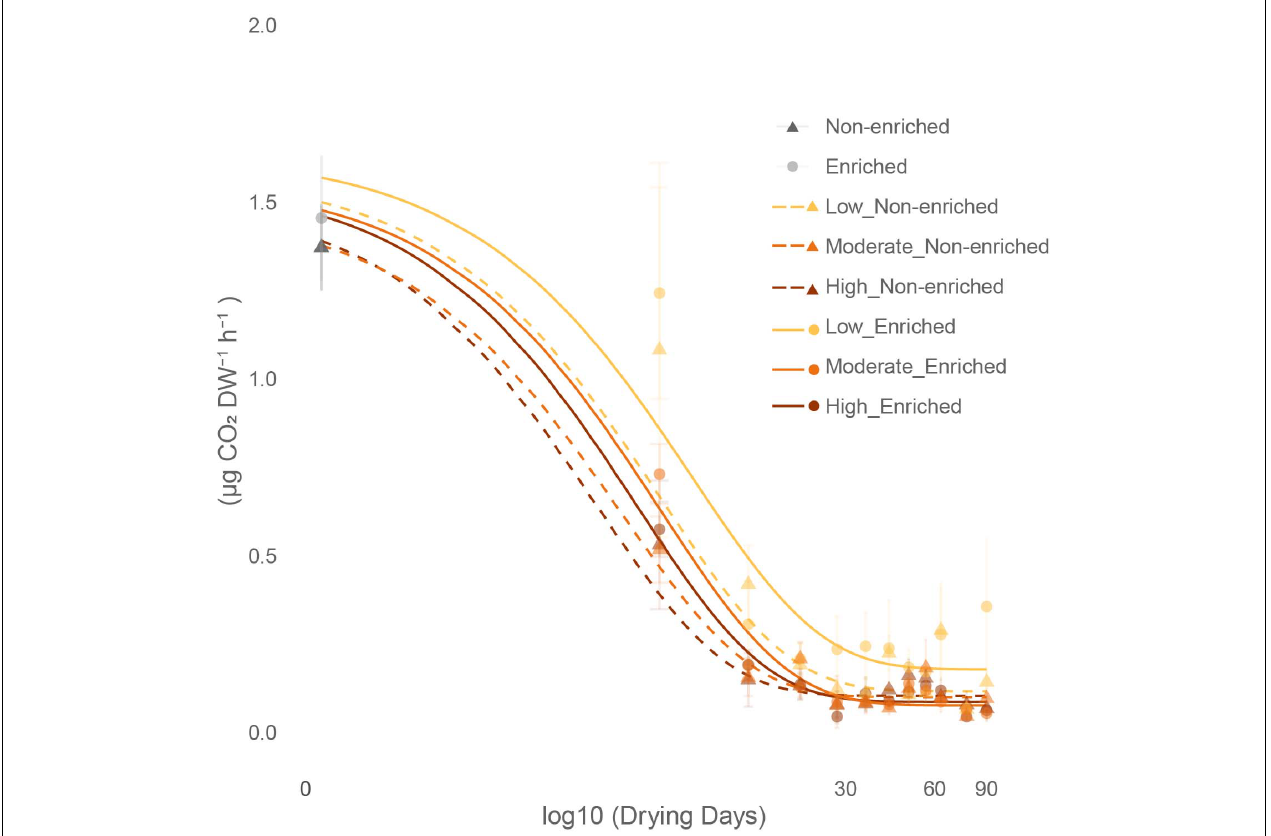
FIGURE 5 | Effect of sediment type (non-enriched or enriched) and drying intensity (low, moderate, or high) on the average (mean + SE, n = 3) CO 2 production decline throughout the drying experiment (0 to 90